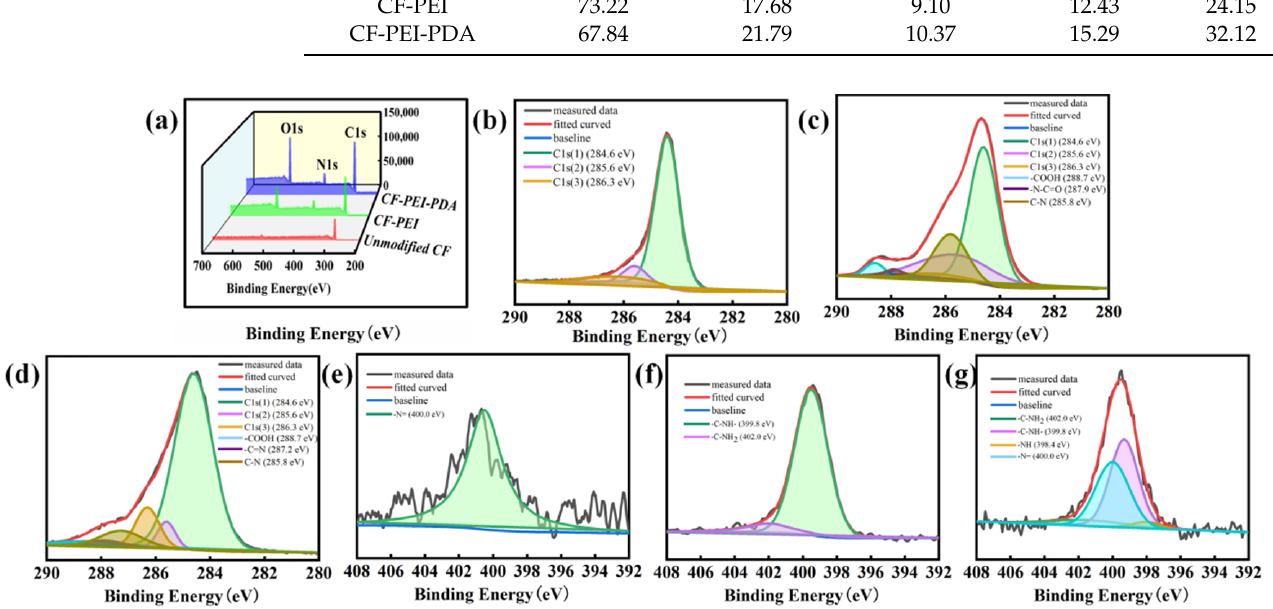
Figure 4. ( a ) Wide-scan XPS spectra for all CFs; C1s and N1s high-resolution XPS spectrum for: ( b , e ) Unmodified CF, ( c , f ) CF-PEI and ( d , g ) CF-PEI-PDA. ( b , e ) Unmodified CF, ( c , f ) CF-PEI and ( d , g )